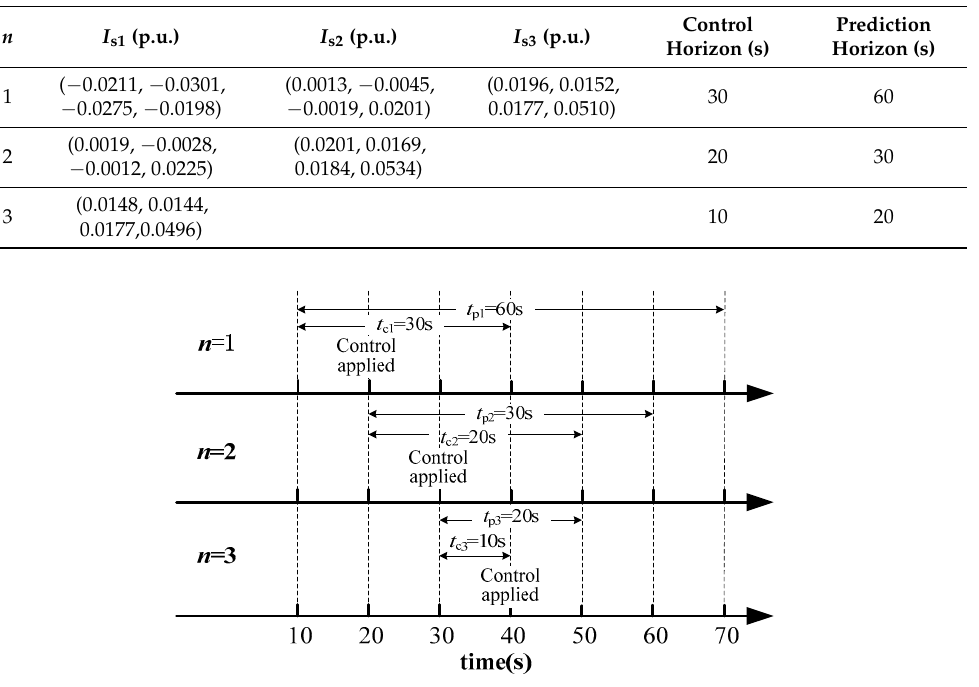
Figure 13. Adaptive horizons applied in case B.